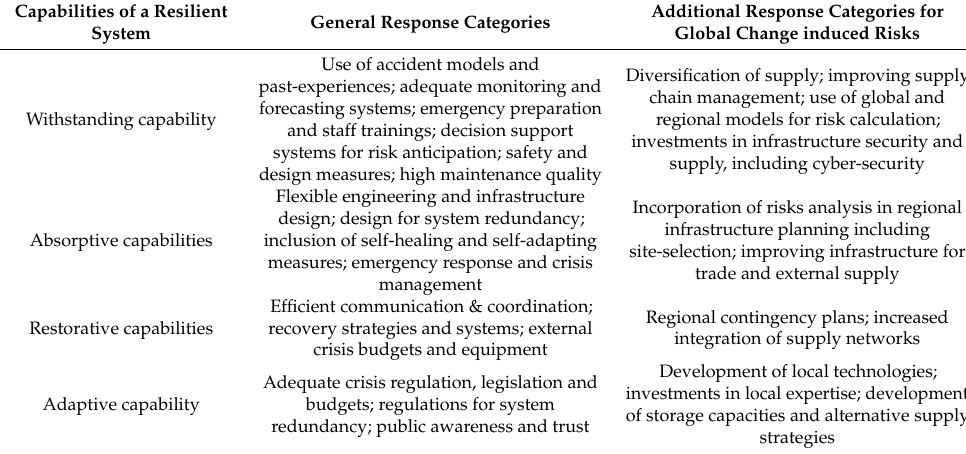
Table 5. Responses for strengthening